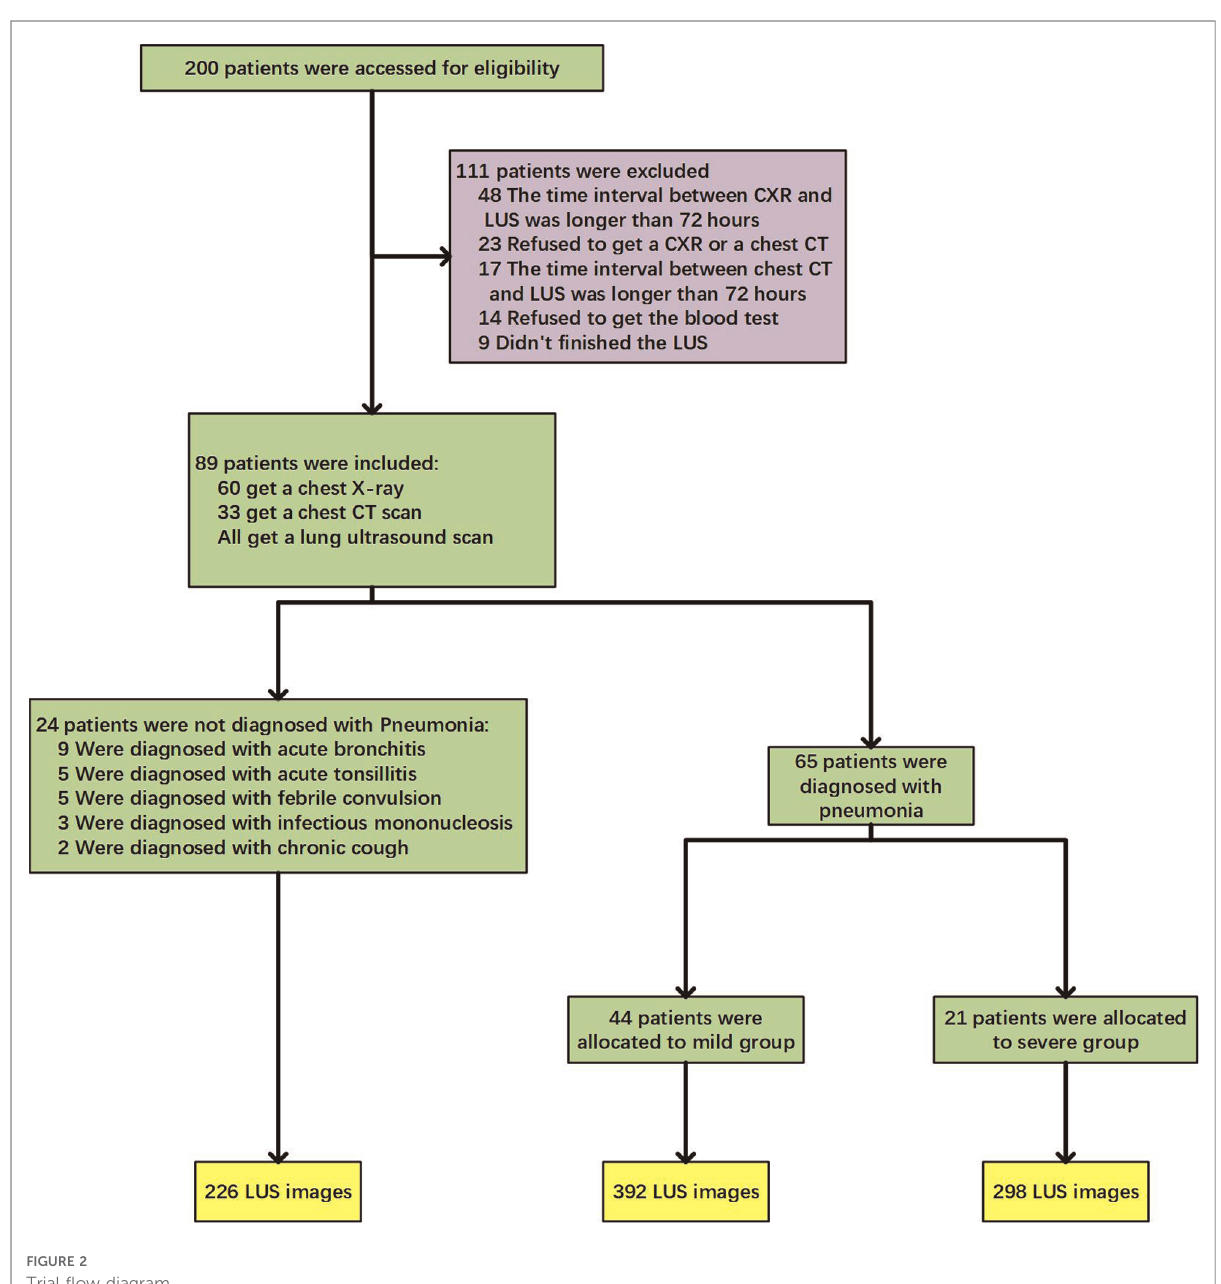
FIGURE 2 Trial fl ow